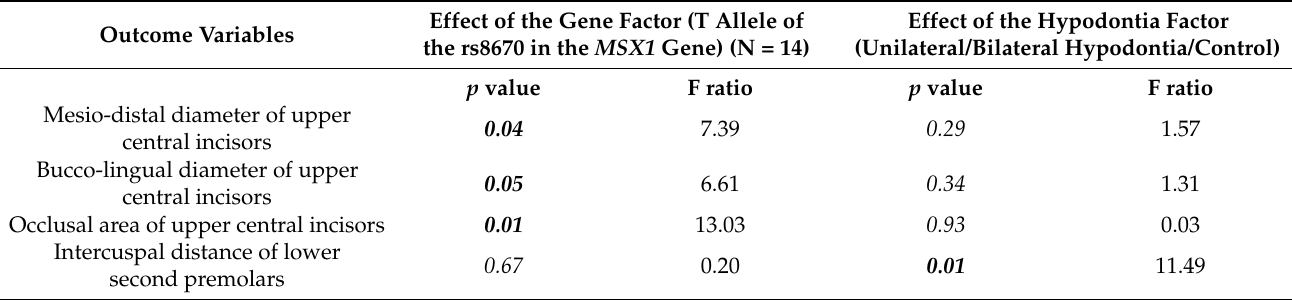
Table 7. Results of the multivariate analysis of variance regarding the effect of the gene factor and the hypodontia factor on relevant